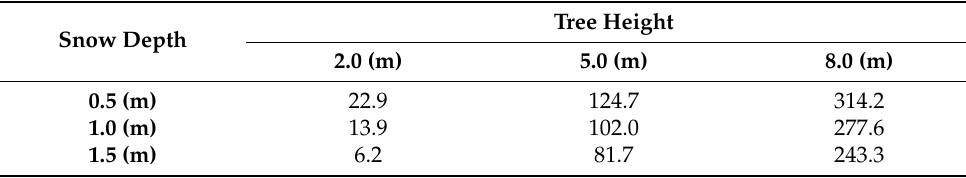
Table 2. Footprint area (m 2 ) for 80% footprints of the downward-looking pyranometer for typical tree heights (m) and snow depths (m) included in the